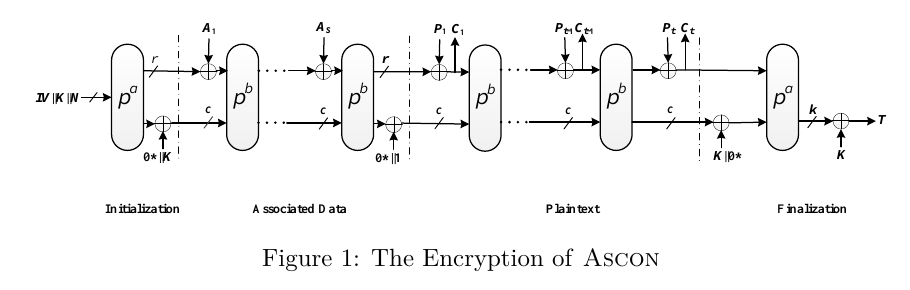
Figure 1: The Encryption of